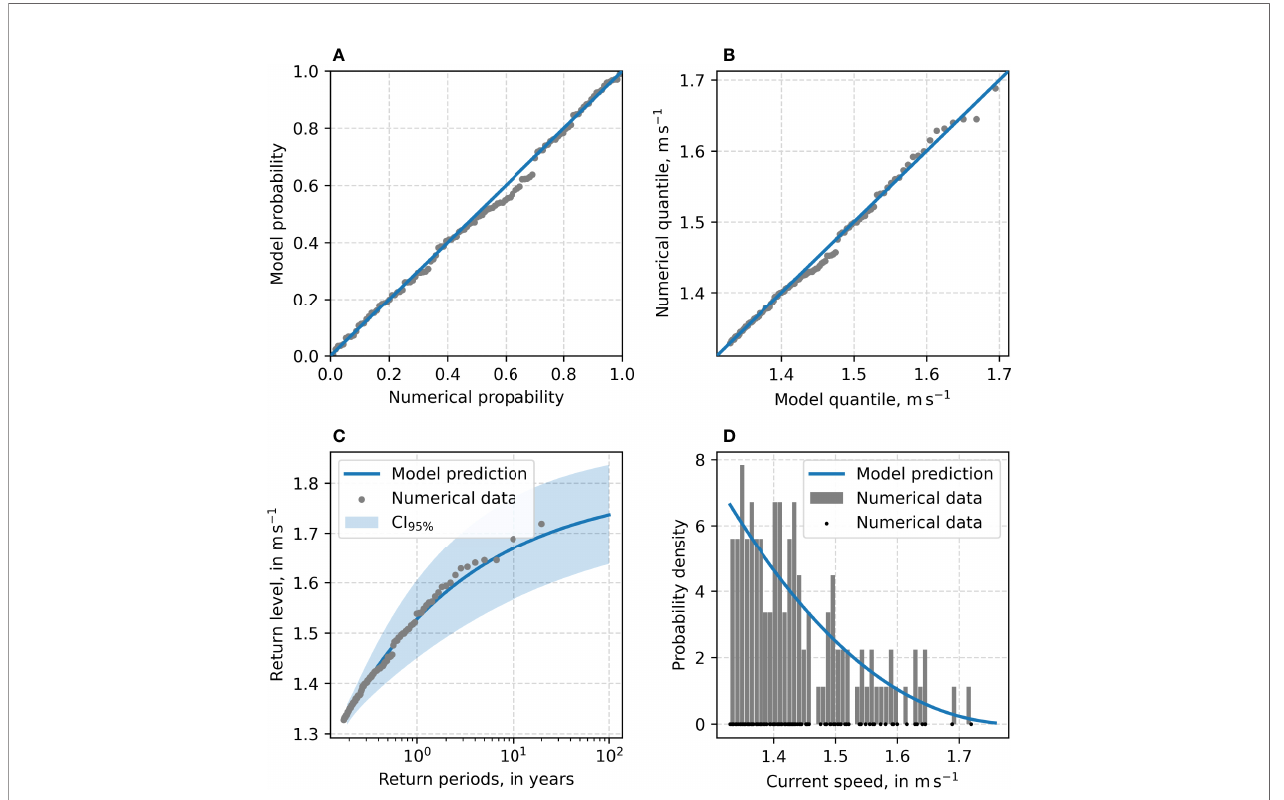
FIGURE 11 | Diagnostic plot for the GPD excess model fi tted to 3-hourly current for the node at P2. (A) p-p plot, (B) q-q plot, (C) return level plot, and (D) density